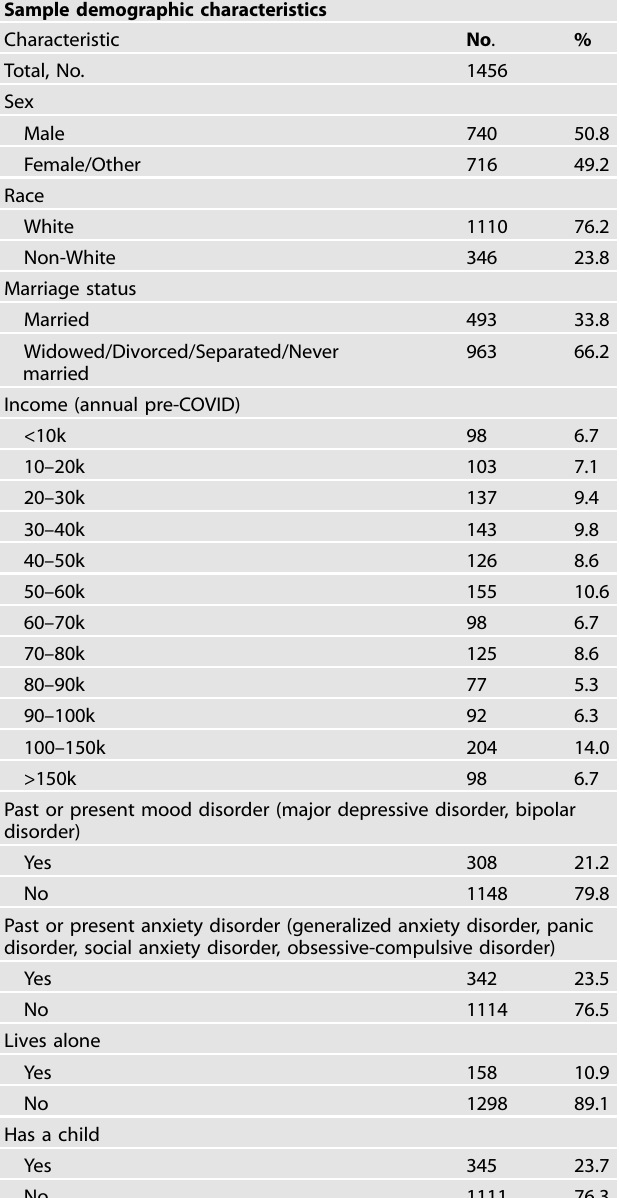
Table 1. Sample demographic